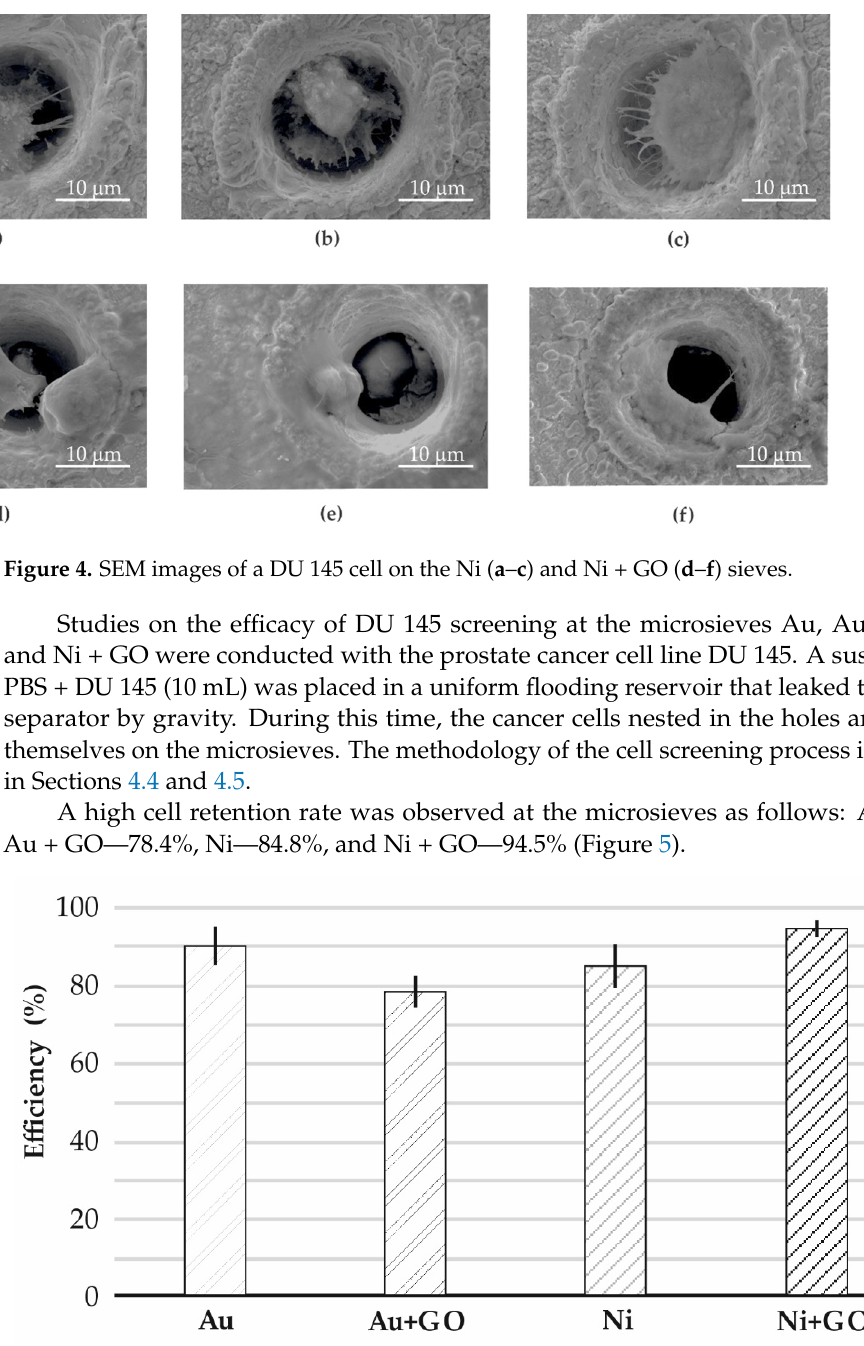
Figure 5. The cell retention efficiency on the microsieves: Au, Au + GO, Ni, Ni + GO.